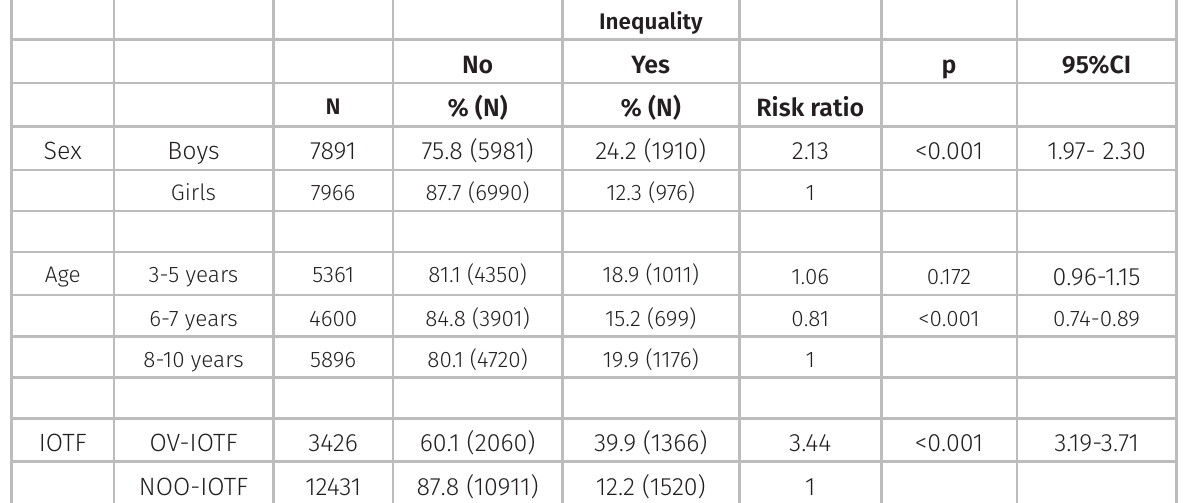
Table III. Percentages and prevalence ratio (PR) for child inequality IOTF vs WHO classification to predictor sex, age group and